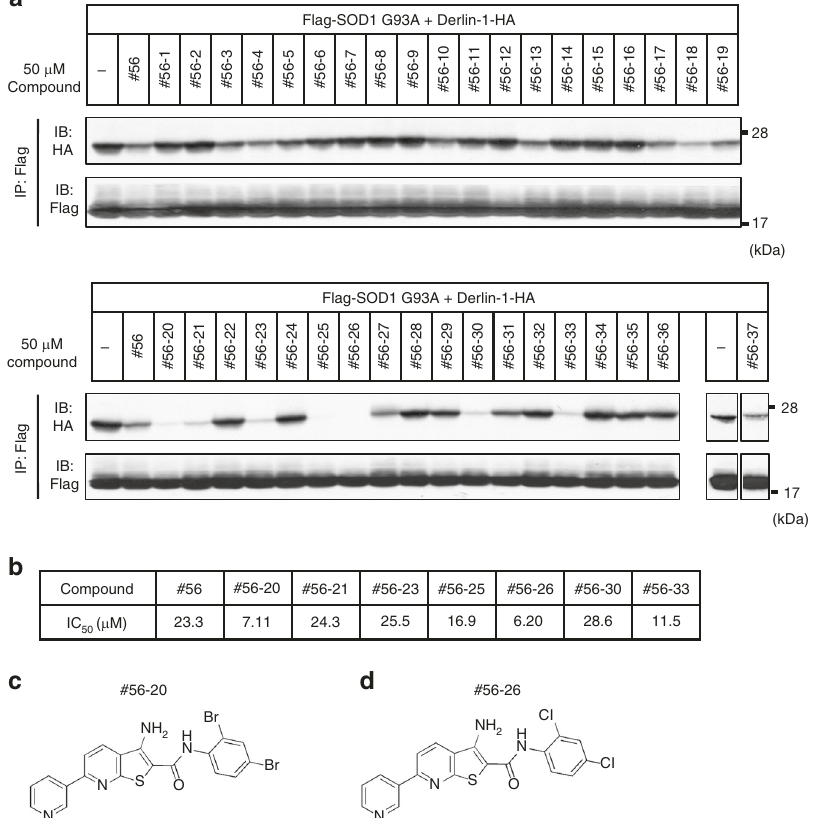
Fig. 2 Compound validation via in vitro assays. a Inhibition of SOD1 G93A -Derlin-1 interaction by #56 analogs in the in vitro immunoprecipitation (IP) assay. Puri fi ed SOD1 G93A -Derlin-1 complex form HEK293A cell lysates transfected with Flag-SOD1 G93A and Derlin-1-HA were incubated with the indicated compounds for 16 h. Then, the complex was immunoprecipitated using anti-Flag beads, followed by immunoblotting (IB) analysis with the indicated antibodies. b IC 50 values of notable #56 analogs and #56 in the in vitro assay. IC 50 values were calculated by generating standard curves. c , d Chemical structure of #56-20 and